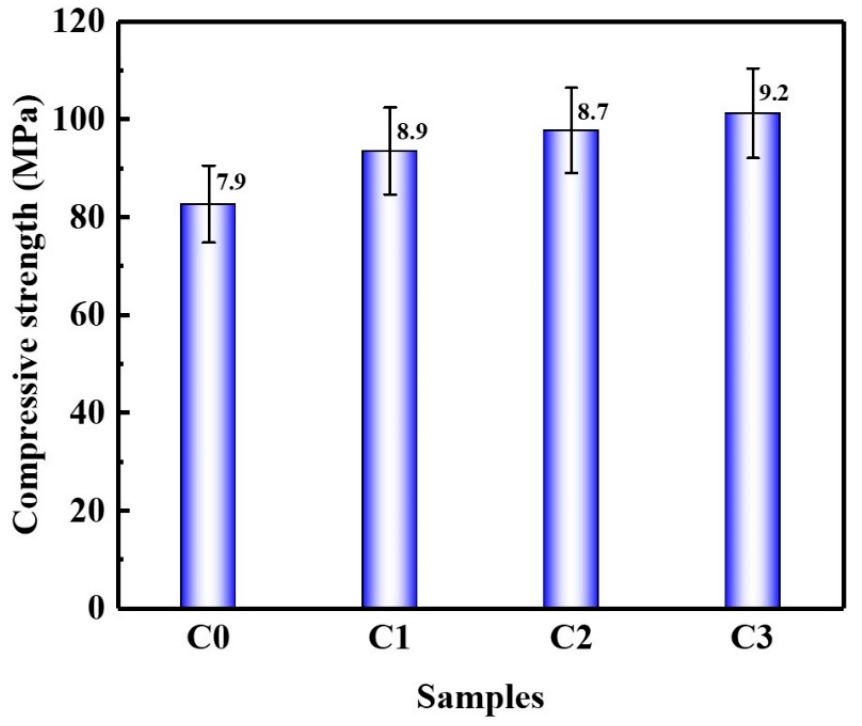
Figure 3. Compressive strength of SAC paste.